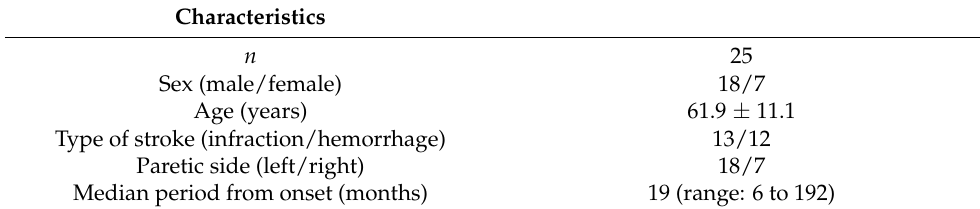
Table 1. Demographic data of the